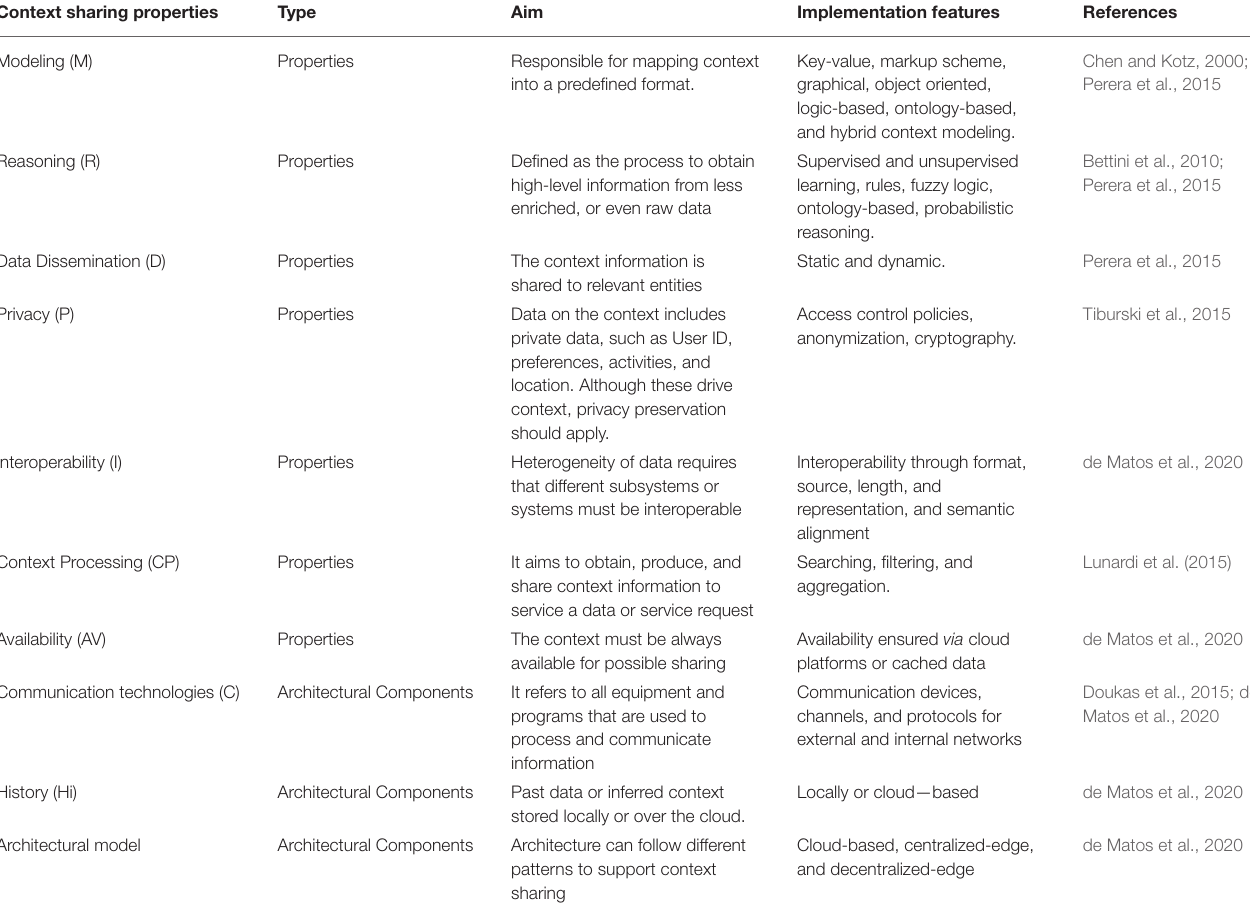
TABLE 3 | Context sharing